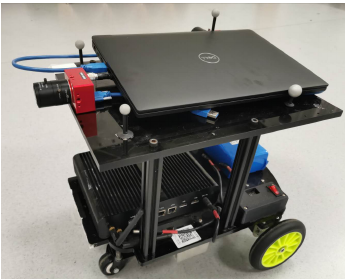
Figure 5. AGV equipped with a forward-facing event camera for vehicle motion